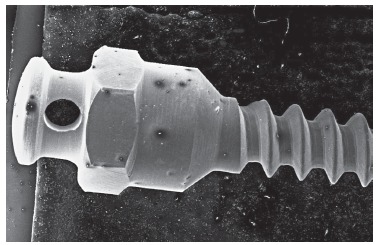
Photomicroscopy of Neodent mini-implant after 60 days of immersion in artificial saliva (50x).